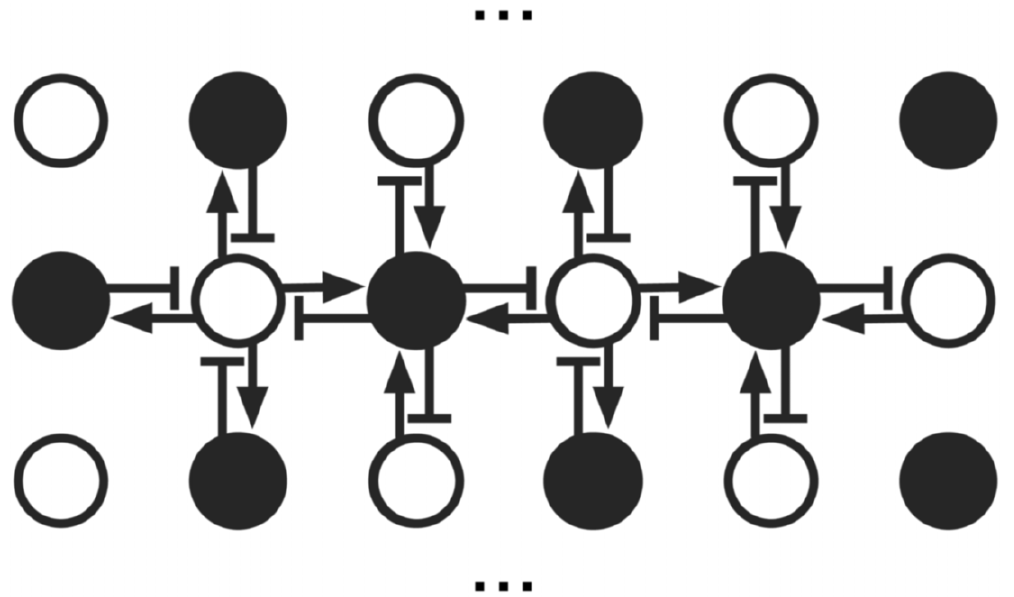
Figure 1. The simplest connectivity of a critically-balanced model of cortex. Black units are inhibitory, white units are excitatory, and all synaptic strengths are identical. Considering a lattice of edge E , and the site at column c and row c gets index i ~ c z Er , then the matrix is